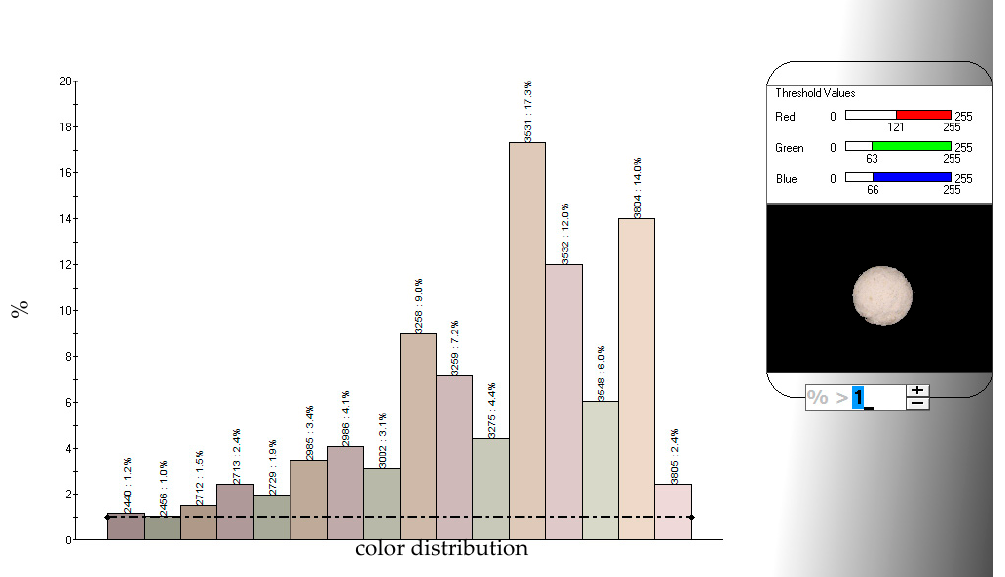
Figure 3. Detailed colour analysis of white garlic from organic cultivation (EG) using the instru ‐ mental method (“electronic eye”) .